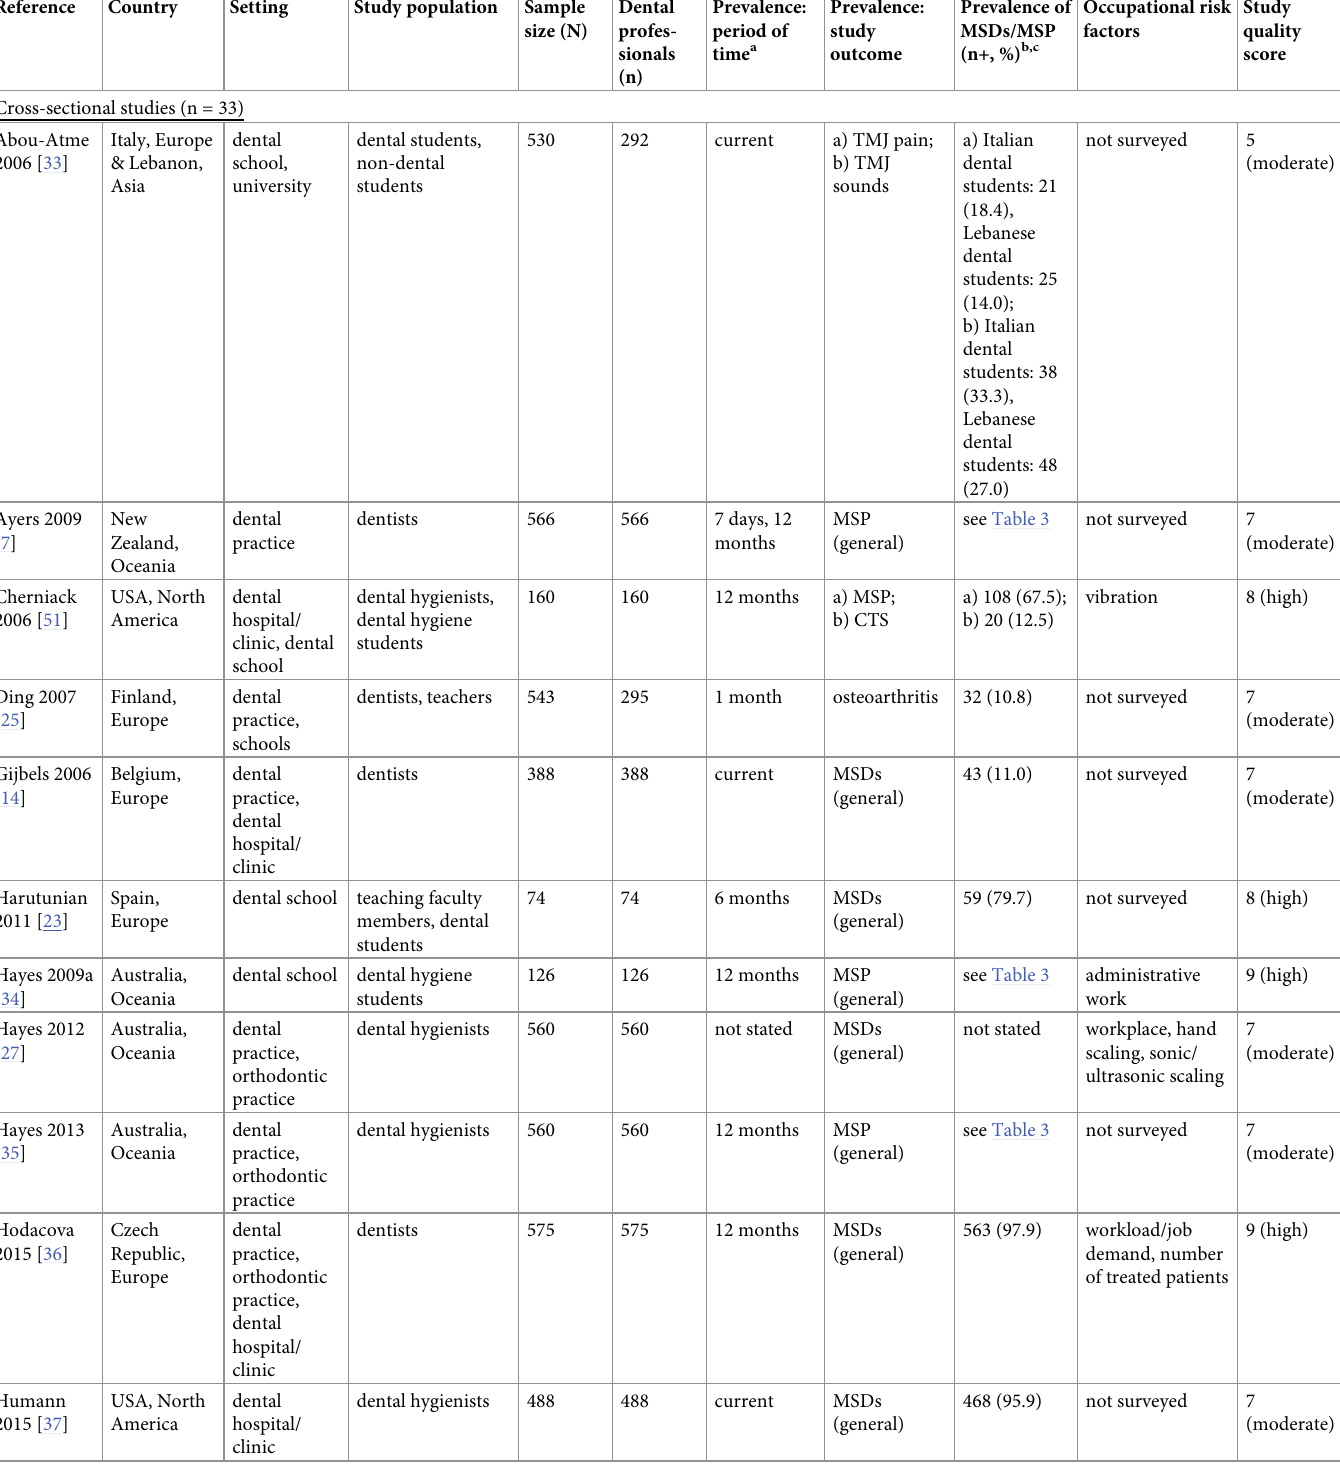
Table 2. Study characteristics of included studies analyzing MSDs/MSP among dental professionals (n =